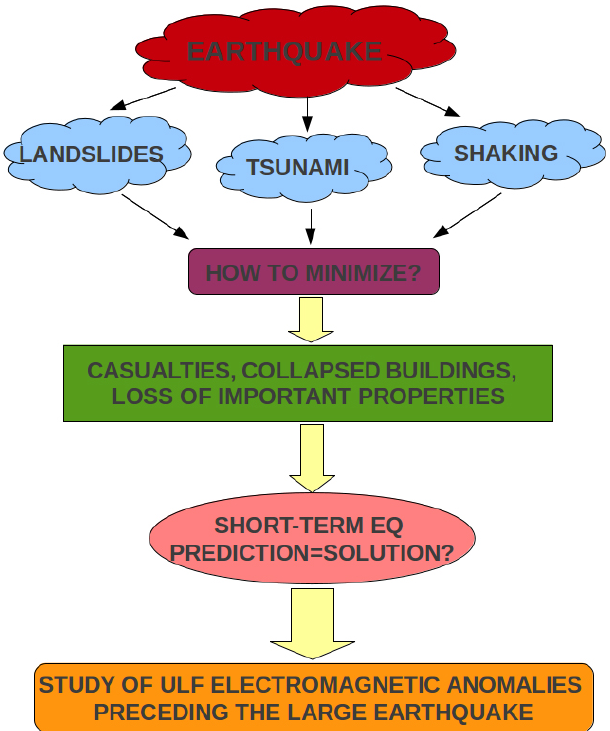
Fig. 2. The concept of EQ prediction research in